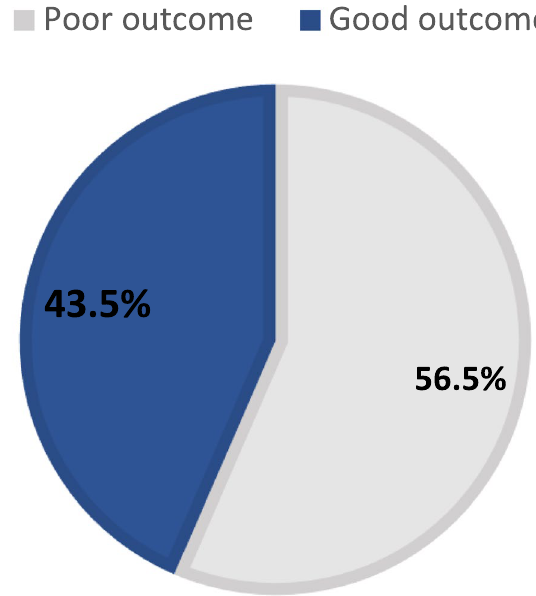
Fig. 1 The quality of life after cochlear implant surgery score based on Glasgow Children’s Benefit Inventory (GCBI) questionnaire. Good outcome indicates score > median of